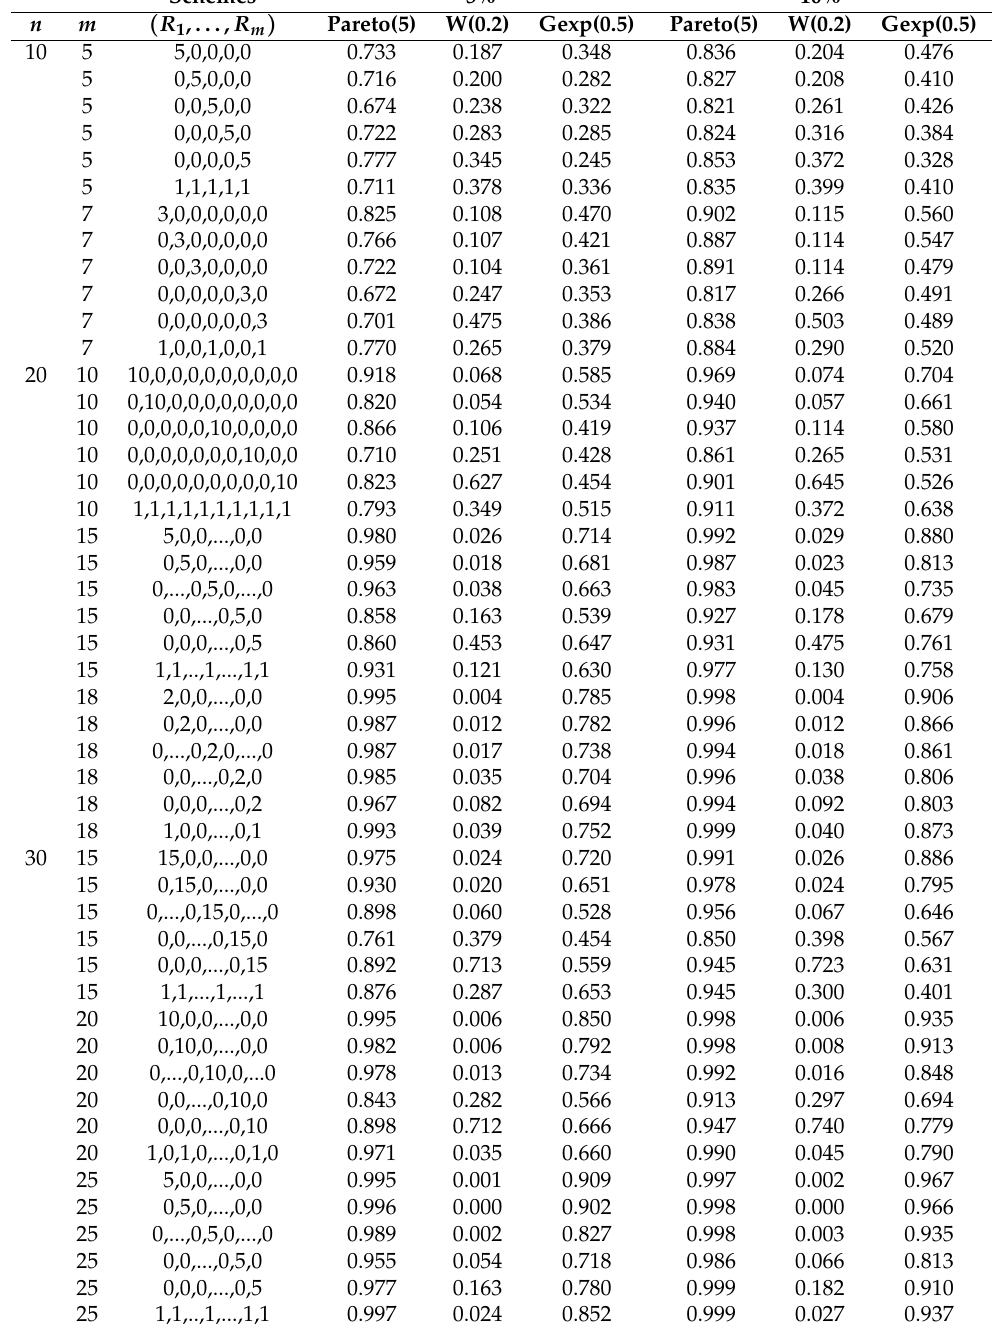
Table 2. Powers of ˆCRKL for the monotone decreasing hazard at the 5% and 10% significance levels for the different censorship schemes in the case of sample sizes n = 10, 20, and